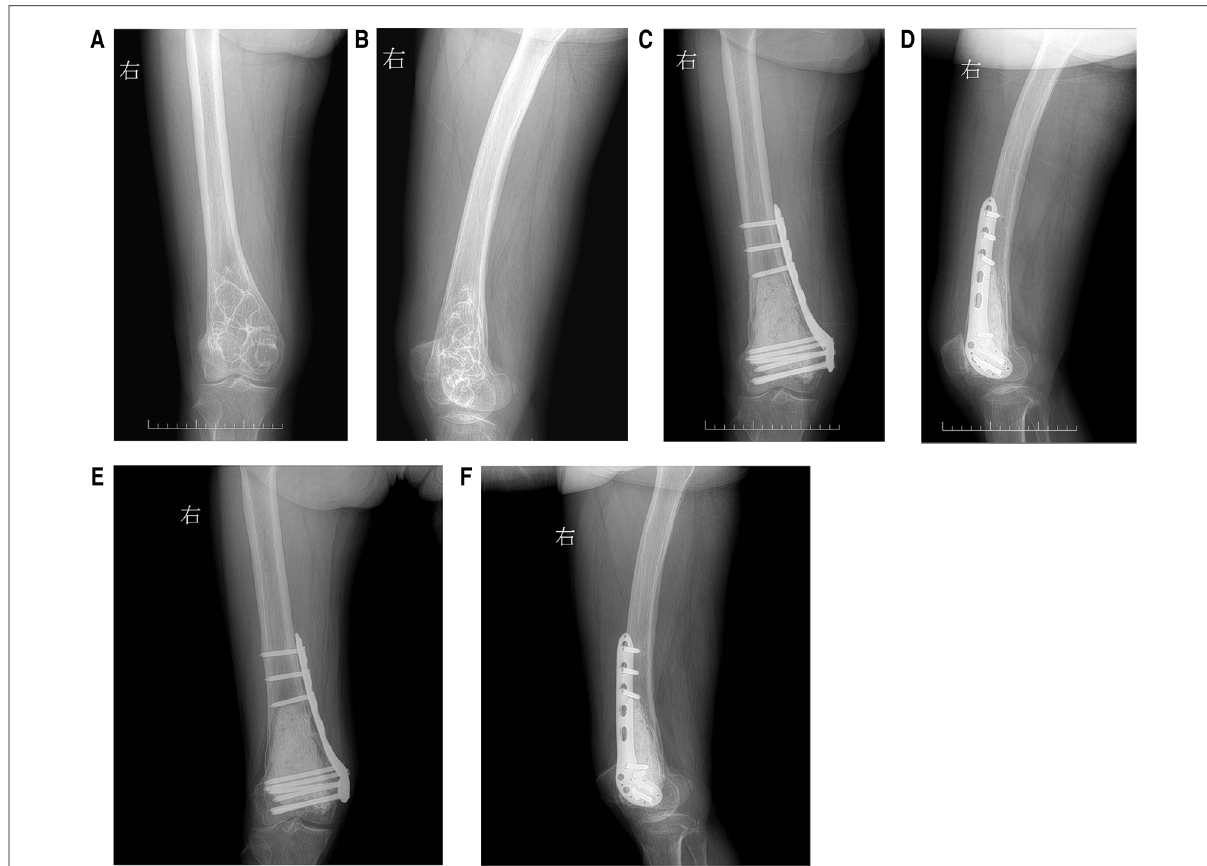
FIGURE 1 ( A ) preoperative anterior x-ray of the right femur was a multilocular cystic low-density focus with hardened edges; ( B ) preoperative lateral x-ray of the right femur; ( C ) fi rst week of the postoperative anterior x-ray of the right femur the bone morphology of the distal right femur was satisfactory, and the internal fi xation position was satisfactory; ( D ) fi rst week of the postoperative lateral x-ray of the right femur the bone morphology of the distal right femur was satisfactory, and the internal fi xation position was satisfactory; ( E ) 15 months of the postoperative anterior x-ray of the right